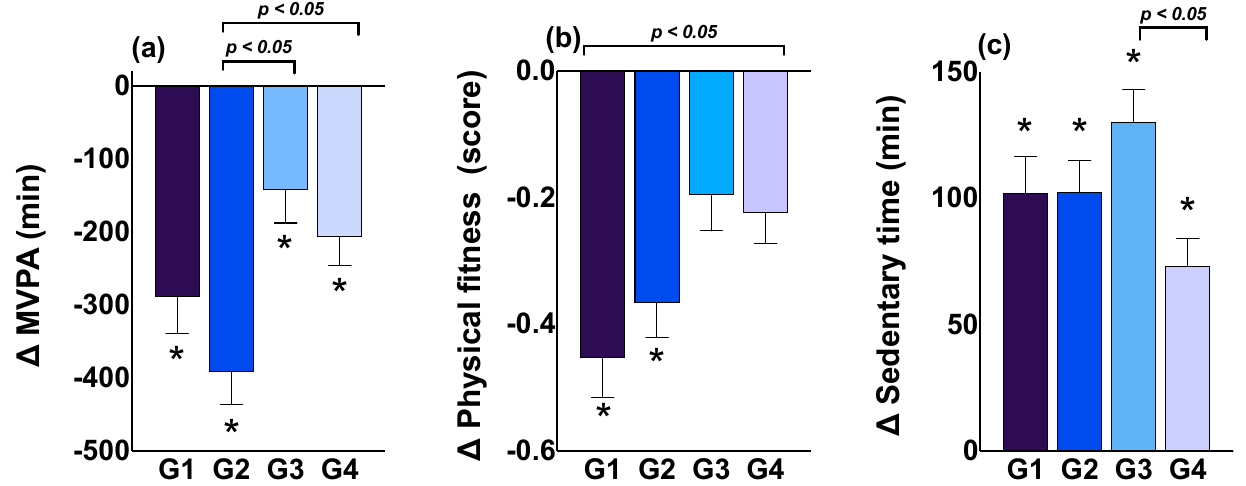
Figure 3. Effect of the COVID-19 pandemic on the variation in MVPA, physical fitness (score), and sedentary time by age group and number of children. ANCOVA models were adjusted by sex of parents and children’s school type; MVPA: moderate-to-vigorous physical activity; * p < 0.05 according to the value before the pandemic. ( a ) Variation before-during the pandemic on MVPA between four groups, ( b ) Variation before-during the pandemic on Physical fitness between four groups, ( c ) Variation before-during the pandemic on Sedentary time between four groups. G1: